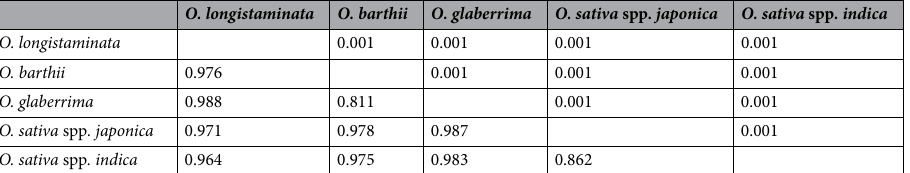
explained 77%, 14% and 6% of the overall variance, respectively (Supplementary Figure S6). The scatter plot of first three PCs revealed five groups in which three were very distinctive (Supplementary Figure S6). As observed with the N-J tree (Fig. 3), some accessions from O. barthii species were very close to O. glaberrima species in the PCA plot (cluster II and III). Genetic distinctness of these rice species/subspecies was evaluated with the 36 diag- nostic markers using DAPC. Bayesian information criterion (BIC) and Silhouette score value revealed K = 5 as the optimal number of clusters, consistent with partitioned variance between these groups of accessions (Fig. 4).